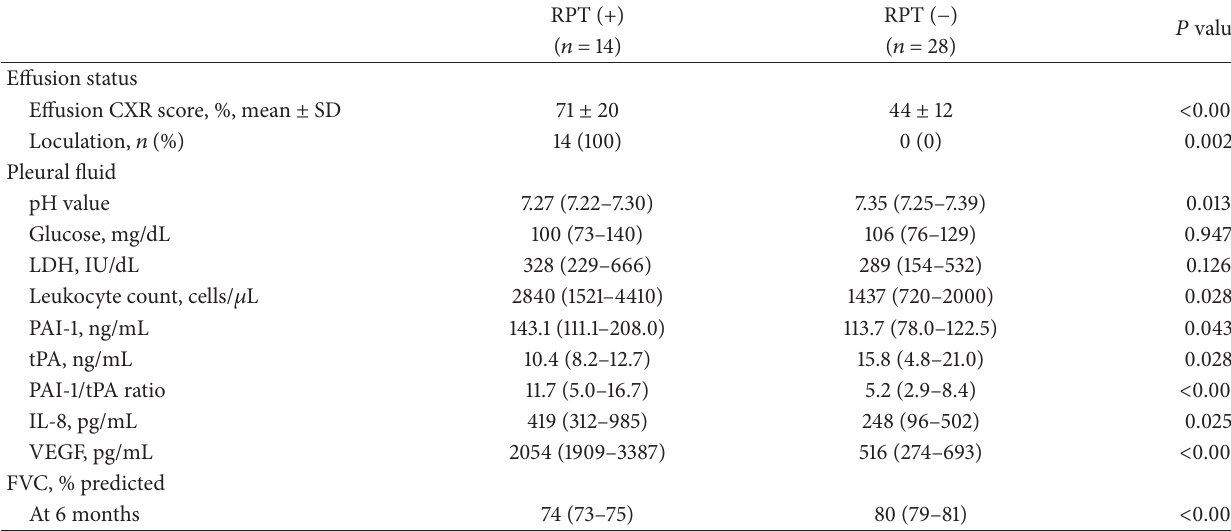
Table 4: Pleural fluid variables and pulmonary function in patients with or without development of residual pleural thickening